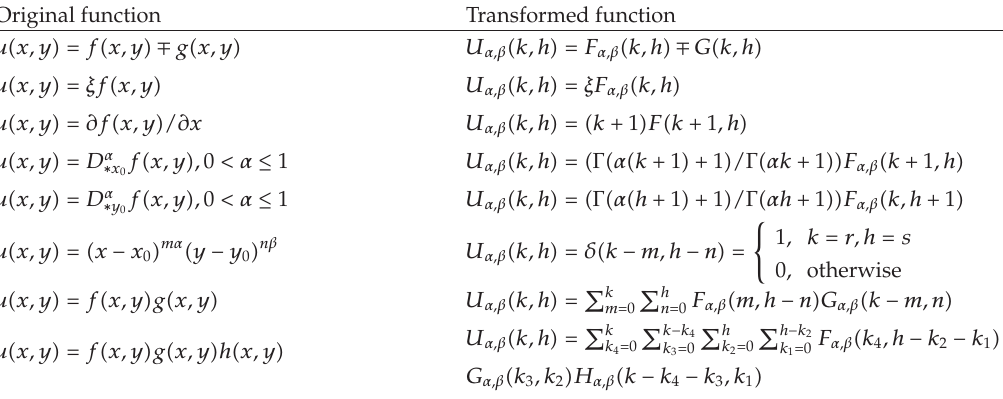
Table 1: Operations of the two-dimensional di ff erential